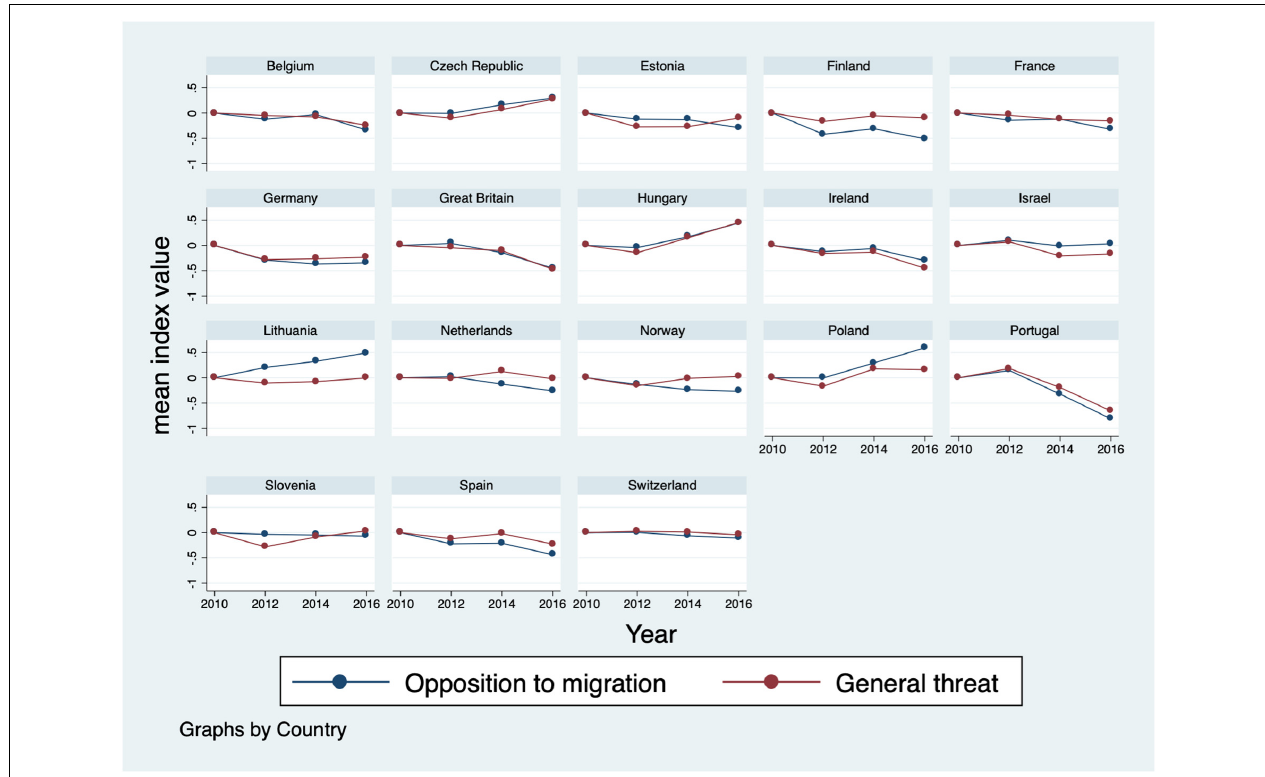
FIGURE 2 | Country specific changes in opposition to migration and general